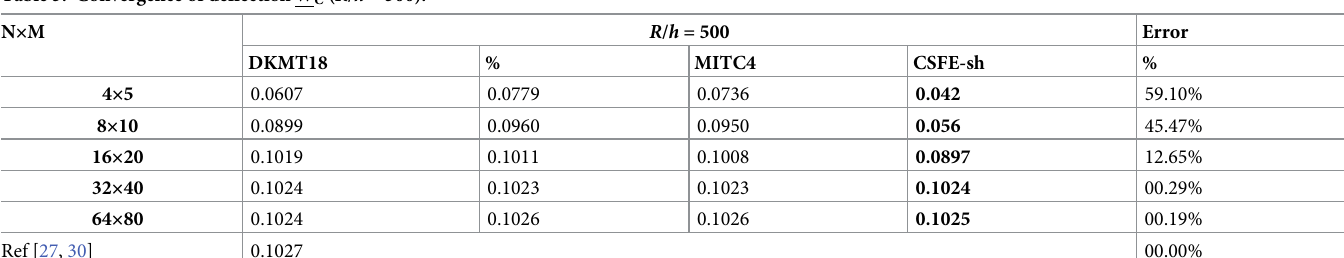
Table 5. Convergence of deflection W C ( R / h = 500).